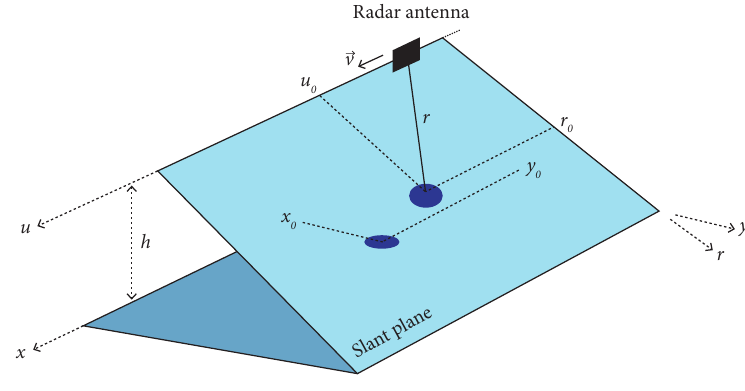
Figure 3. Point target and slant plane